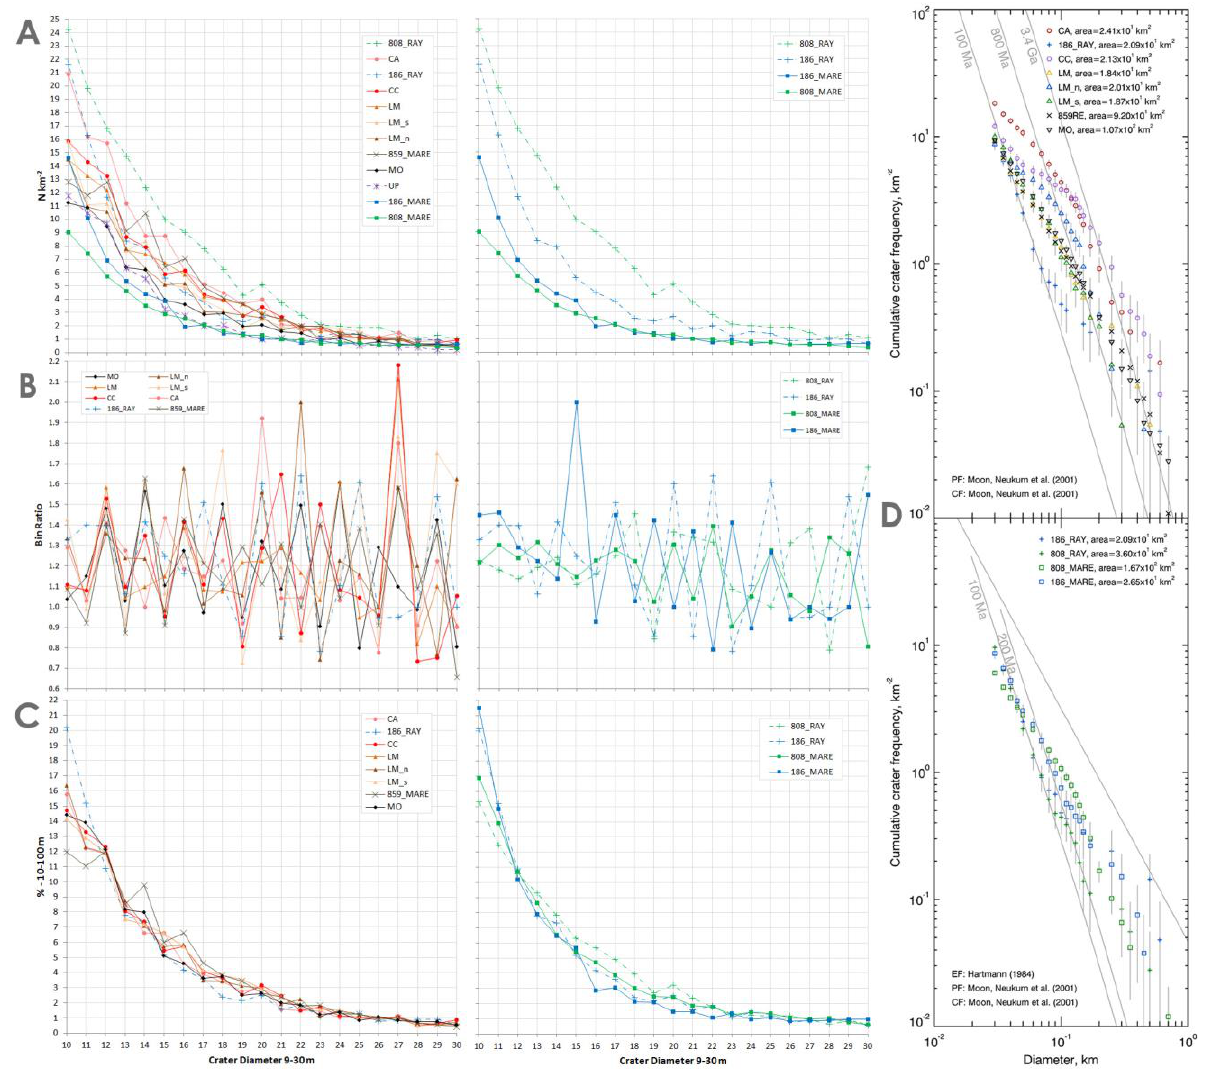
Figure 2 . A – histogram of number of craters per 1 m bin size per km -2 (i.e., density); B – ratio between adjacent Nkm -2 bins; C – bin sizes 10 to 100 m factorised to unit, in this case 100 to give percentage; D – pseudo-log binned histogram for sizes >30 m using CraterstatsII (Michael and Neukum, 2010). Each data point is not fit to isochrones, which are drawn for reference